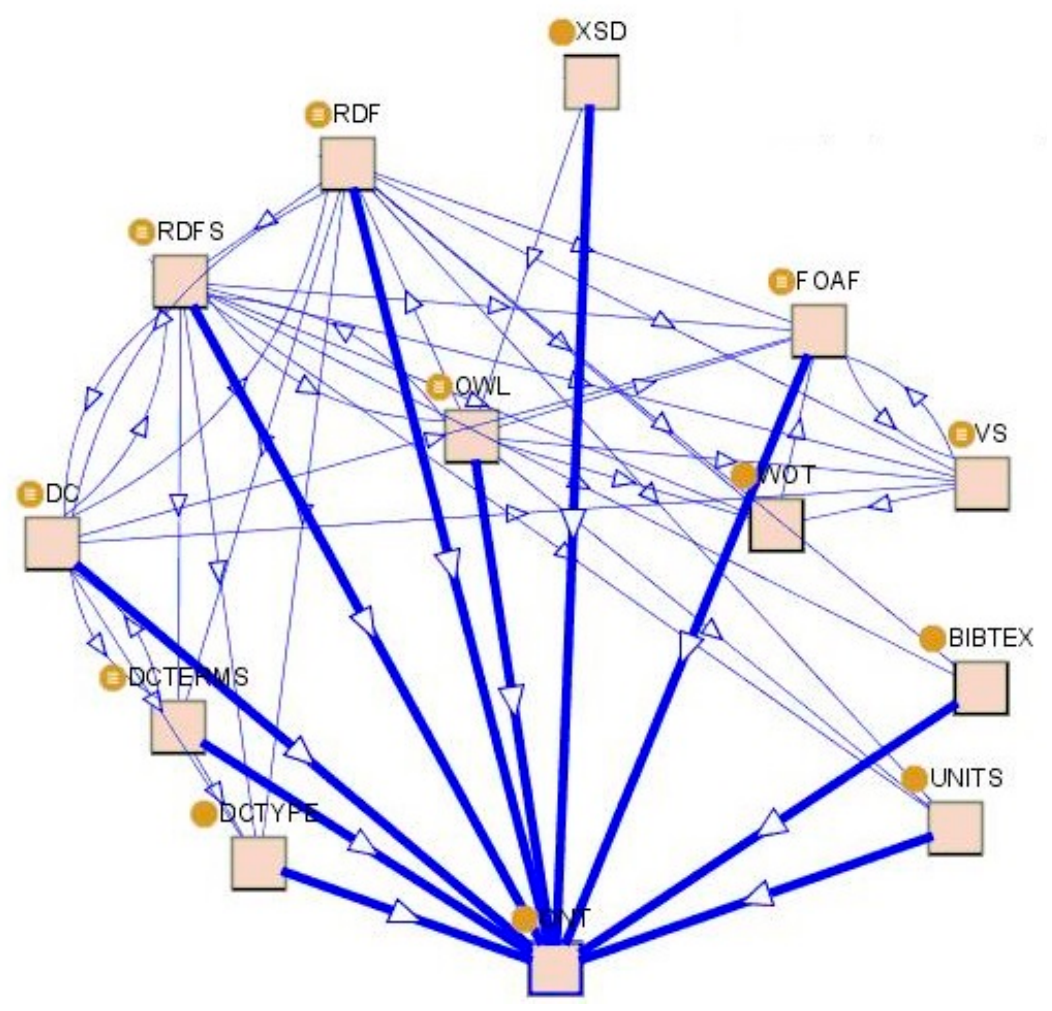
Figure 7. Structure of the nodes and import of ontologies.